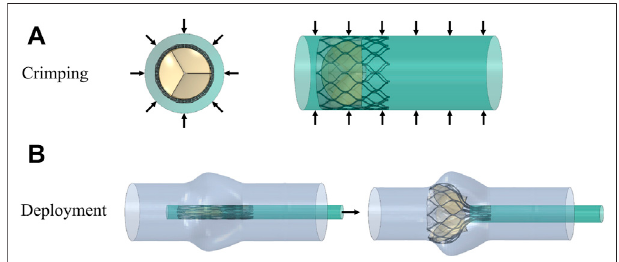
FIGURE 4 | Schematic diagram of the valve stent intervention process, (A) stent crimping by applying a radial displacement on an outer cylindrical surface and (B) progressive deployment of the crimped